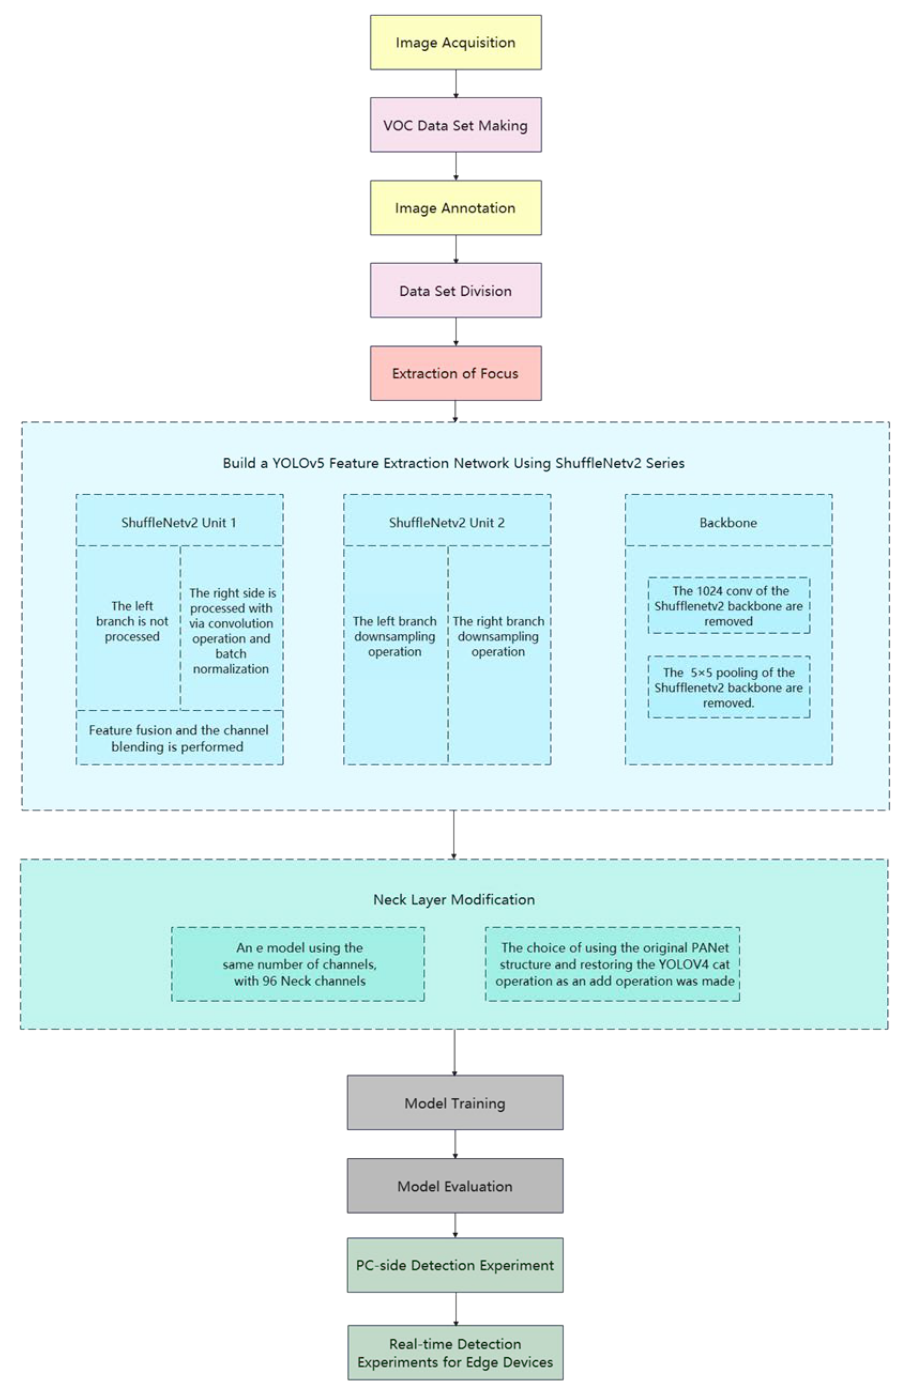
Figure 3. YOLOv5 network improvement step diagram.